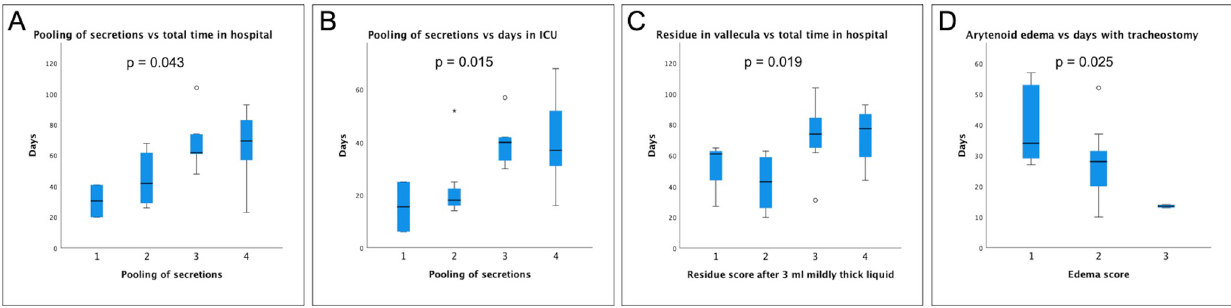
shorter duration with tracheostomy with more prominent edema in the arytenoid region. There was no correlation between the number of days with endotracheal intubation and swal- lowing and abnormal laryngeal findings. The post-hoc analysis indicates that there was a significant difference between patients with different ratings of pooling of secretions in relation to the total time in hospital (rho = 0.52, p = 0.008; Kruskal-Wallis H = 8.16, p = 0.043; n = 25) and the number of days in the ICU (rho = 0.58, p = 0.002; Kruskal-Wallis H = 10.47, p = 0.015; n = 25), i.e., more severe ratings of secretion were associated with a longer total time in hospital and in the ICU (Fig 4). In addi- tion, there was a difference between degrees of residue in the vallecula after 3 ml of mildly thick liquid with regard to total time in hospital (rho = 0.56, p = 0.006; Kruskal-Wallis H = 9.95, p = 0.019; n = 23) (Fig 4). Patients with low ratings of arytenoid edema differed sig- nificantly from patients with higher ratings with respect to the number of days with tracheos- tomy (rho = -0.61, p = 0.004; Kruskal-Wallis H = 7.39, p = 0.025; n = 20) (Fig 4).